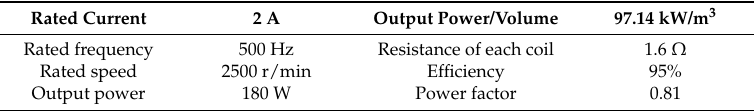
Figure 20. Variation of power factor versus load current (2500 r/min). Table 4. Nominal characteristics of the generator with FST-shaped iron bars.